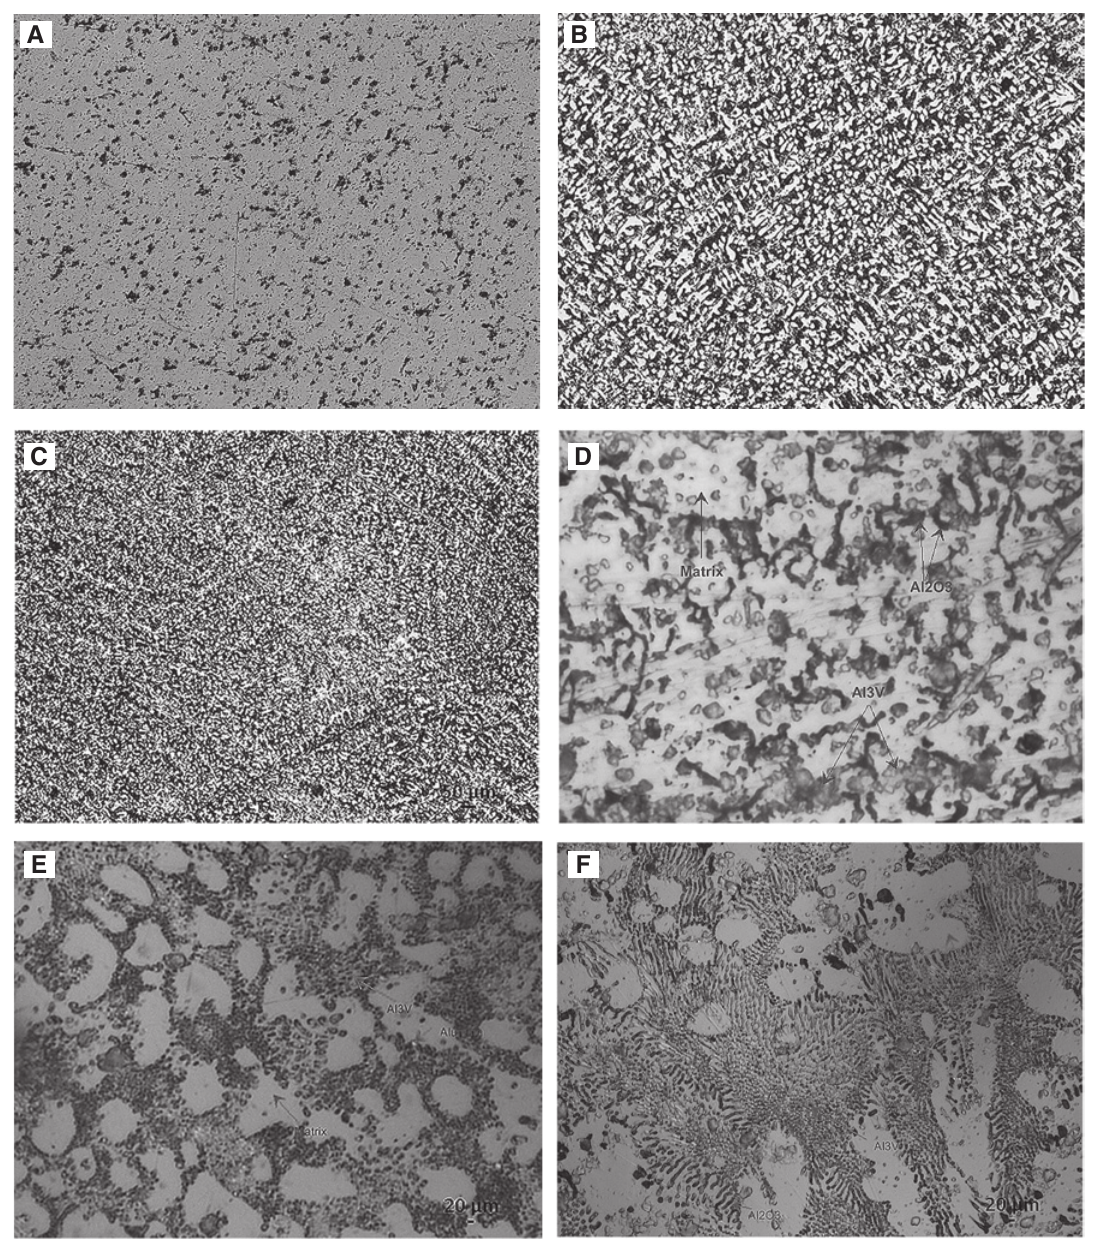
O ; (C) Al-5% V O at low magnification; (D) Al-5% V 2 5 2 5 O at high magnification. 2 5